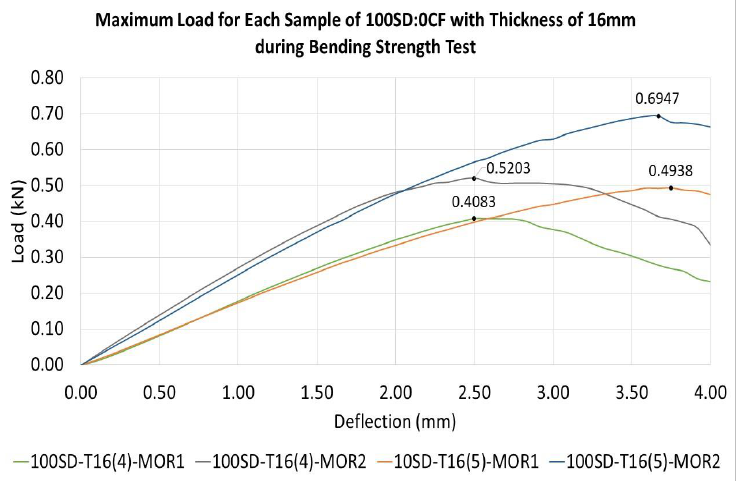
Figure 14. Load Against Deflection in Bending Test for Board 100SD:0CF in Thickness Group 16 mm .